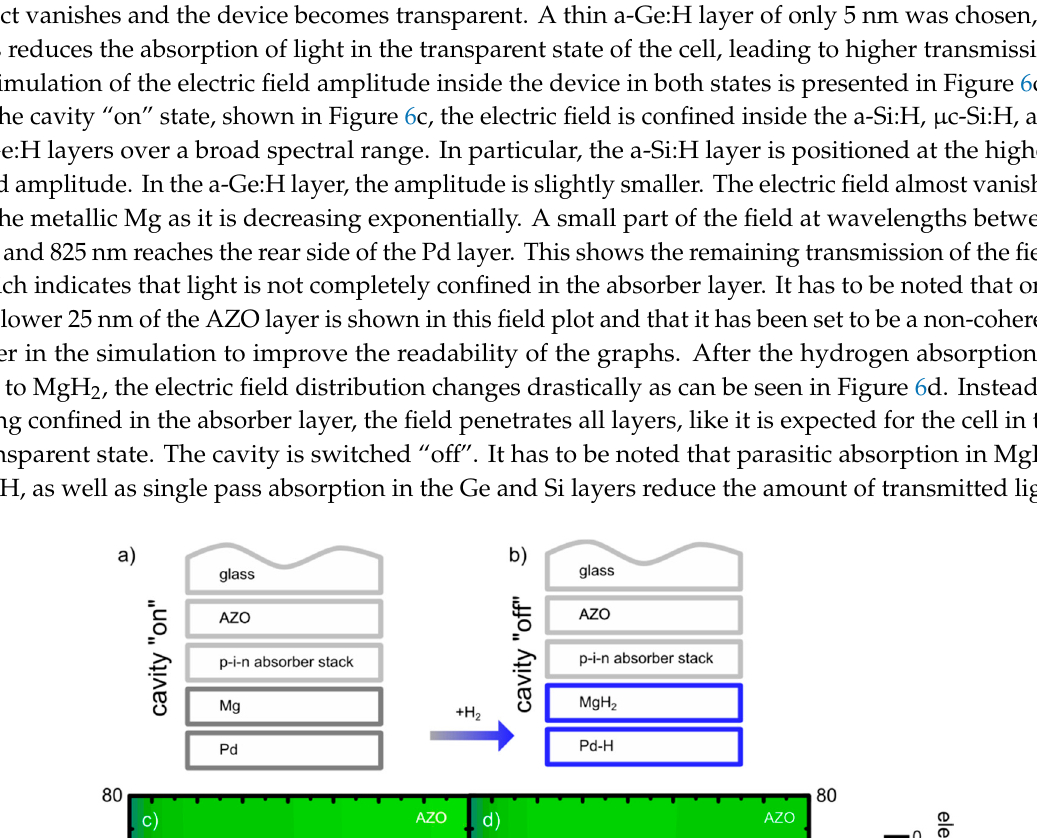
e ff ect vanishes and the device becomes transparent. A thin a-Ge:H layer of only 5 nm was chosen, as this reduces the absorption of light in the transparent state of the cell, leading to higher transmission.